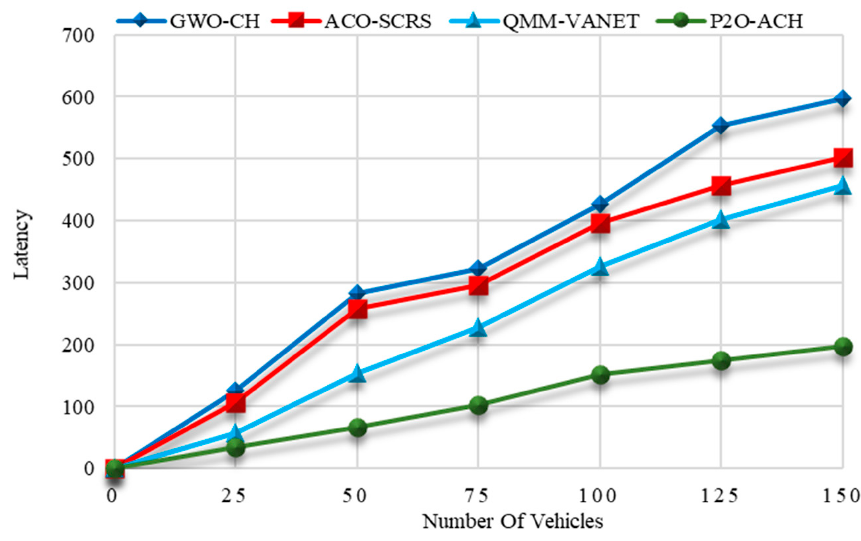
Figure 7. Latency Calculation. Table 7. Performance Values of Packet Delivery Ratio and Latency Calculation of the Network. S. No